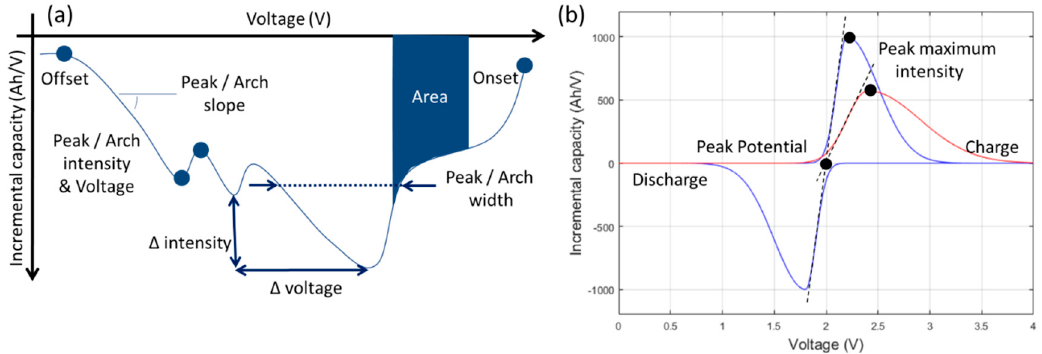
Figure 7. ( a ) Feature of interest (adapted from [53] ) and ( b ) incremental capacity (IC) peak description.